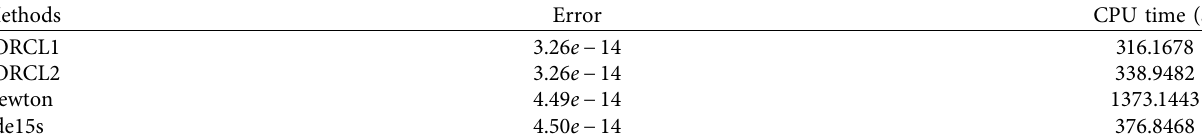
Table 5: Numerical comparison for diferent methods, with ω � 1 . 9 and θ � 1/2 for SORCL1 and SORCL2 methods.